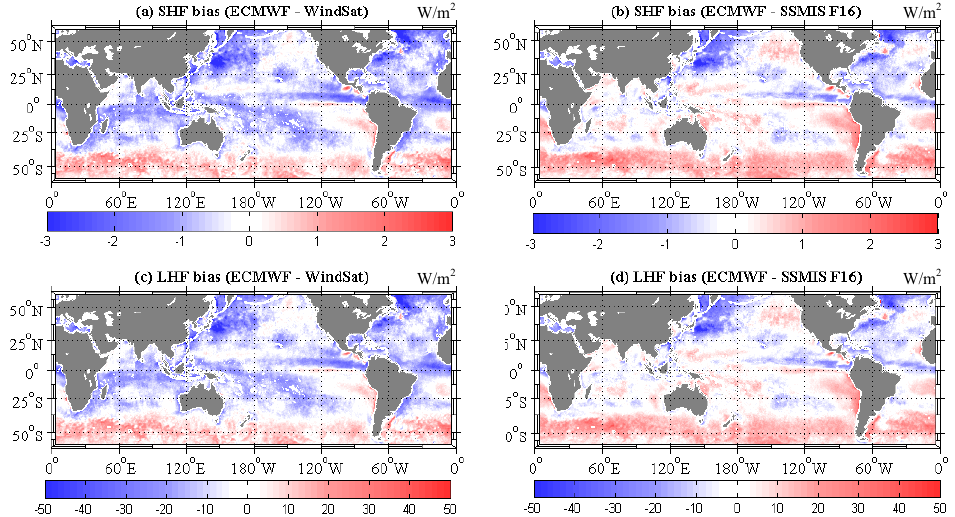
Figure 10. ( a ) The difference between ECMWF-derived SHF and WindSat-derived results; ( b ) the difference between ECMWF-derived SHF and SSMIS F16-derived results; ( c ) the difference between ECMWF-derived LHF and WindSat-derived results; and ( d ) the difference between ECMWF-derived LHF and SSMIS F16-derived results.